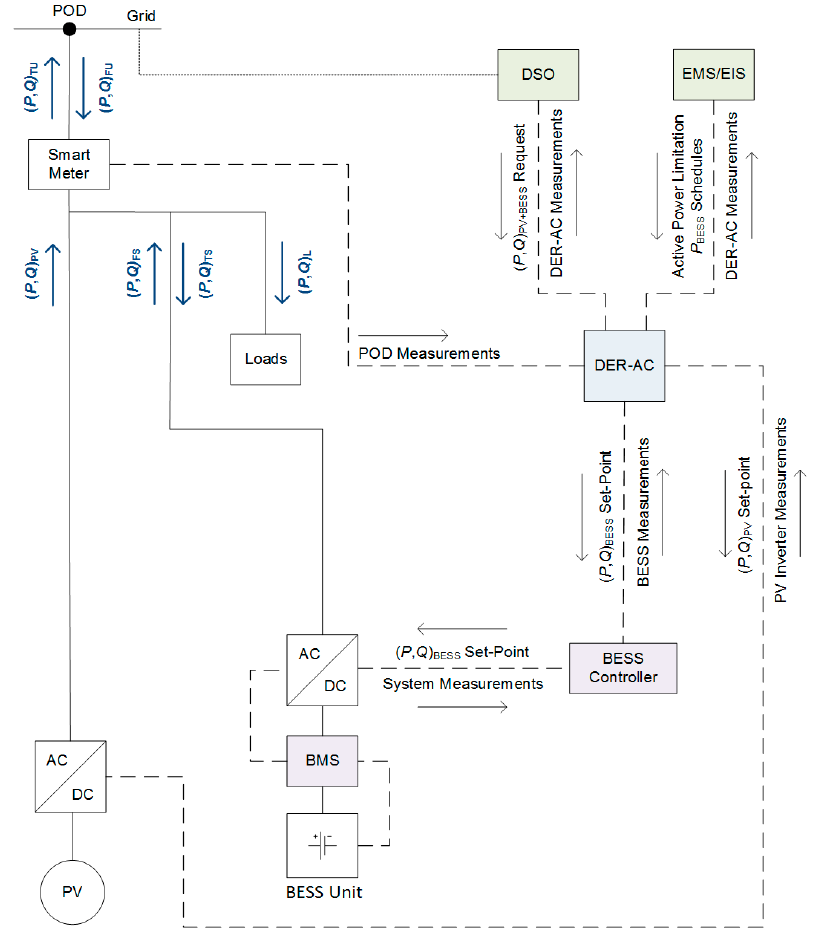
Figure 7. Simplified architecture of the DER Automated Controller. BESS: Battery Energy Storage System; BMS: Battery Management System; DC: direct current; EMS: Energy Management System.